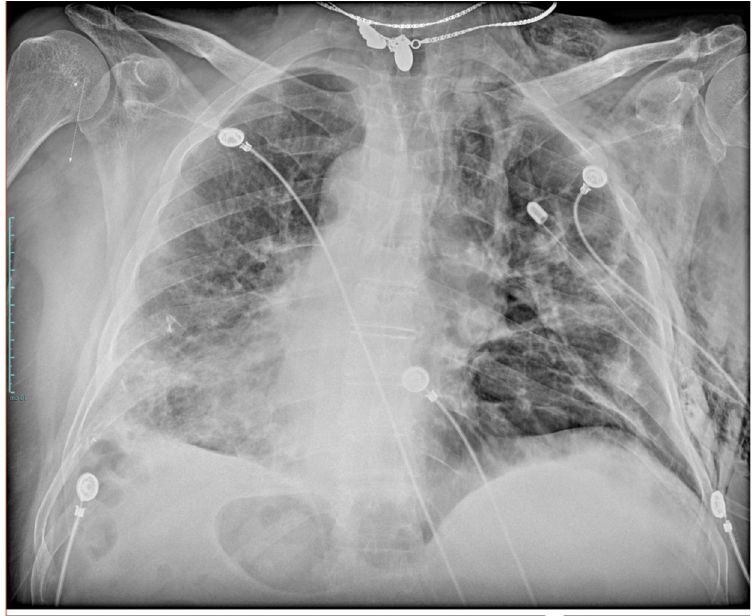
Figure 1. Chest X-ray showing right-sided chest tube placed for pneumothorax and mediastinal emphysema in COVID-19 patient.